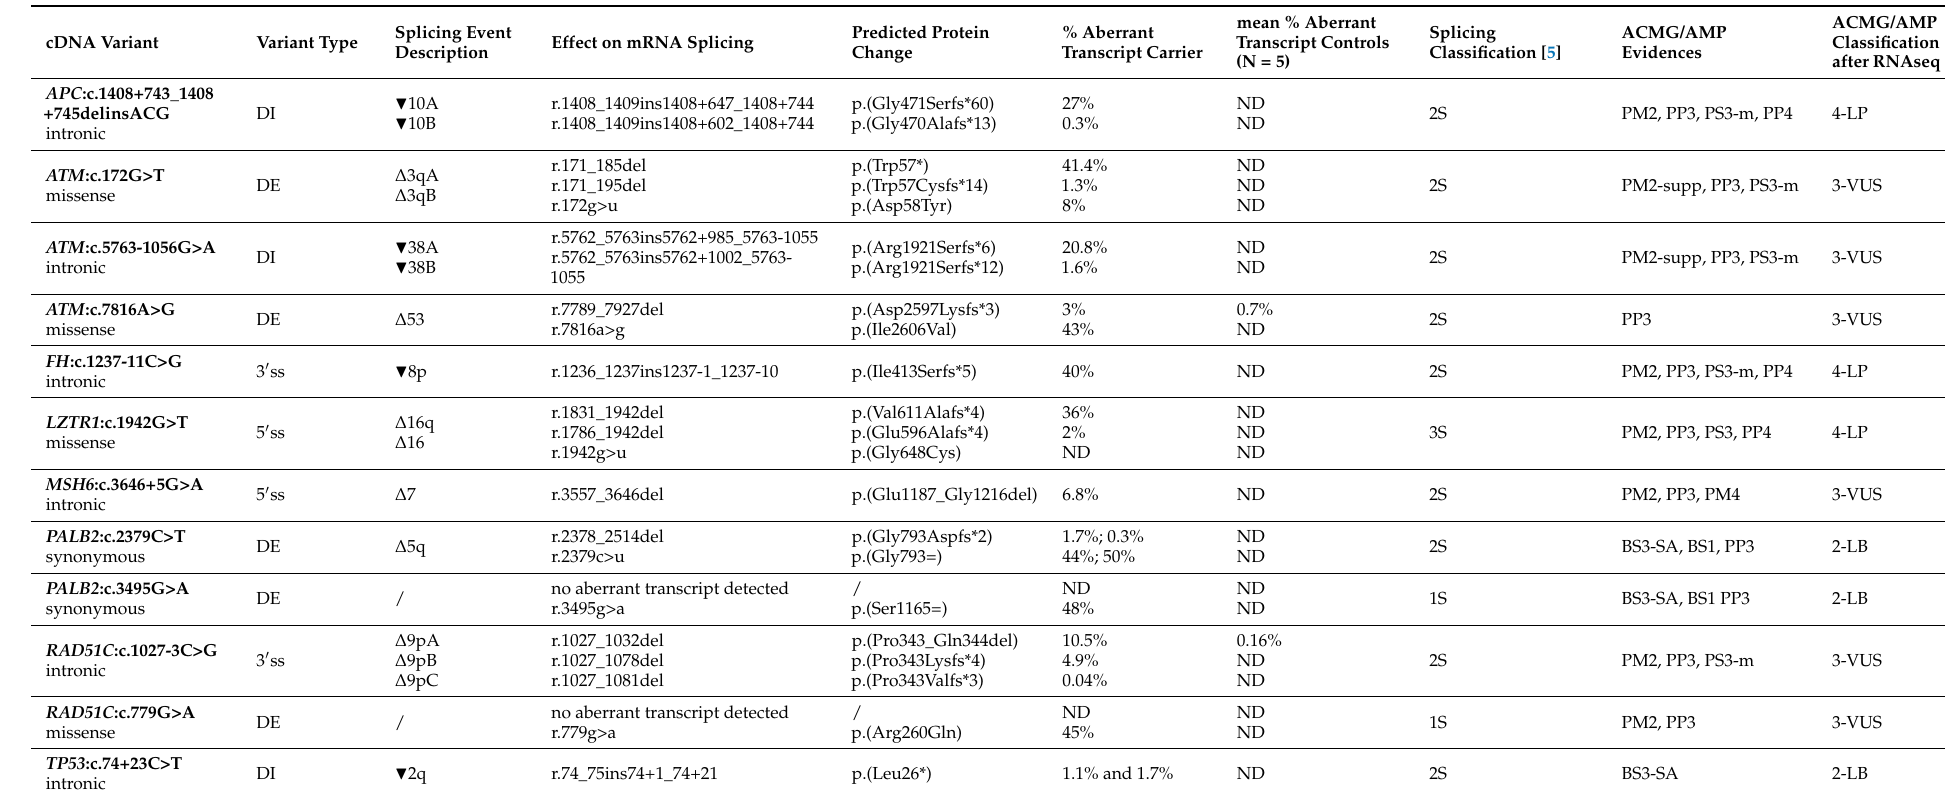
Table 1. Variants’ effect on mRNA splicing (detected with RNAseq) and final variant